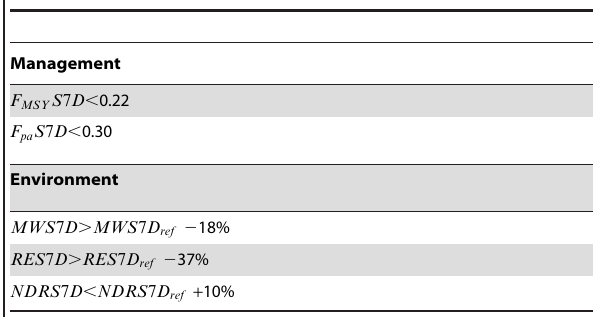
Table 9. Management parameters values identified from leaf 3 and environmental variability they allow dealing with. For sole in subarea